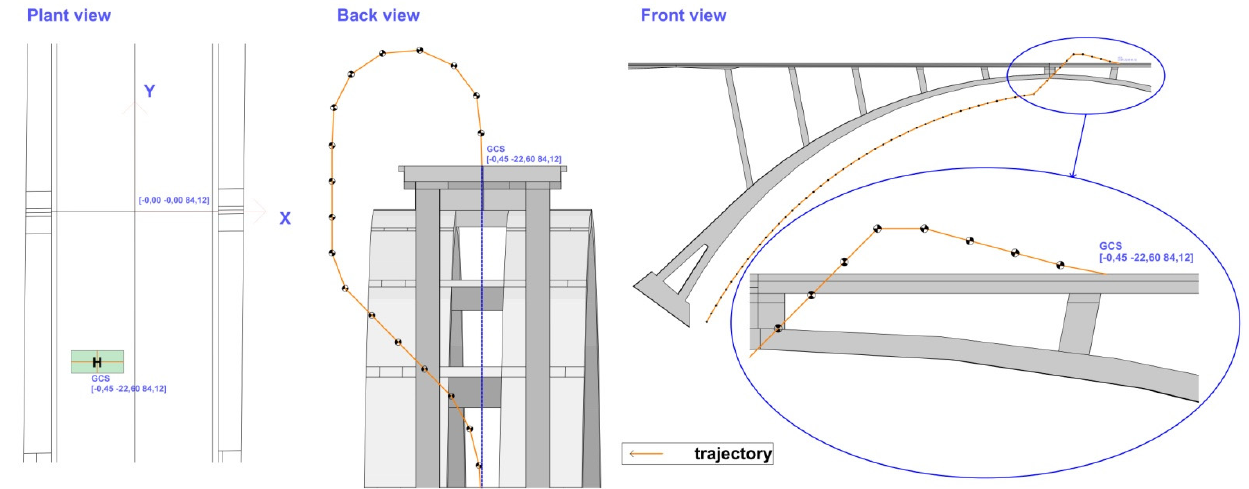
Figure 5. Morandi Bridge (Catanzaro, Italy) plant, back and right view: trajectory and virtual waypoints in Archicad.